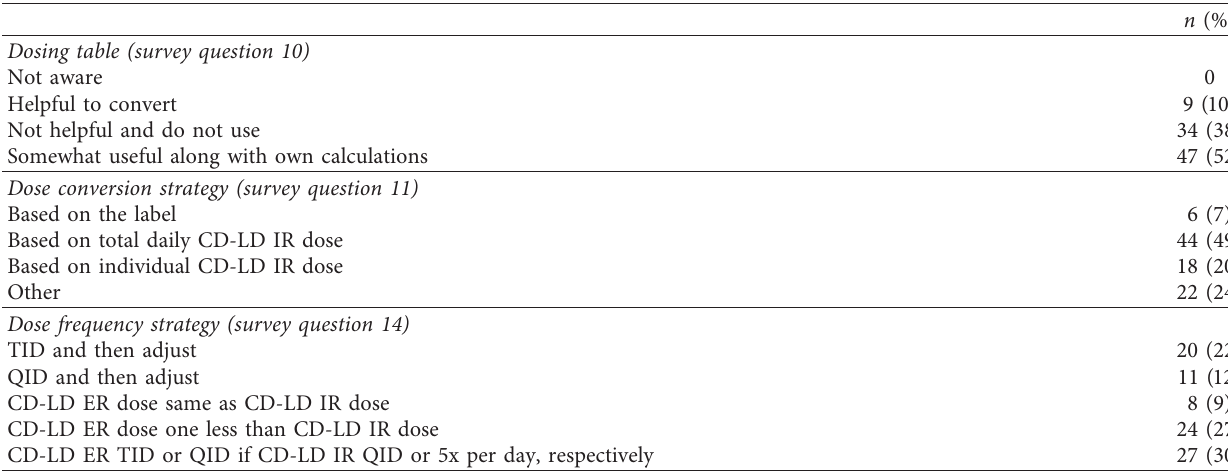
Figure 1: Respondents success rate of CD-LD IR to CD-LD ER conversion. Table 2: Strategy for determining CD-LD ER dose and frequency ( N � 90).